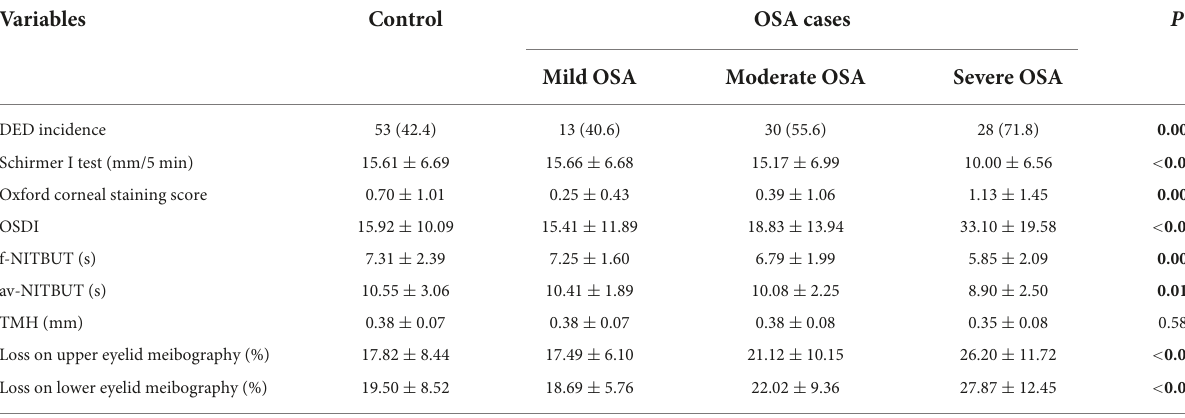
TABLE 2 Incidence of DED, DED-related parameters, and comprehensive analysis of ocular surface among OSA cases in different stages and the relevant controls. Variables